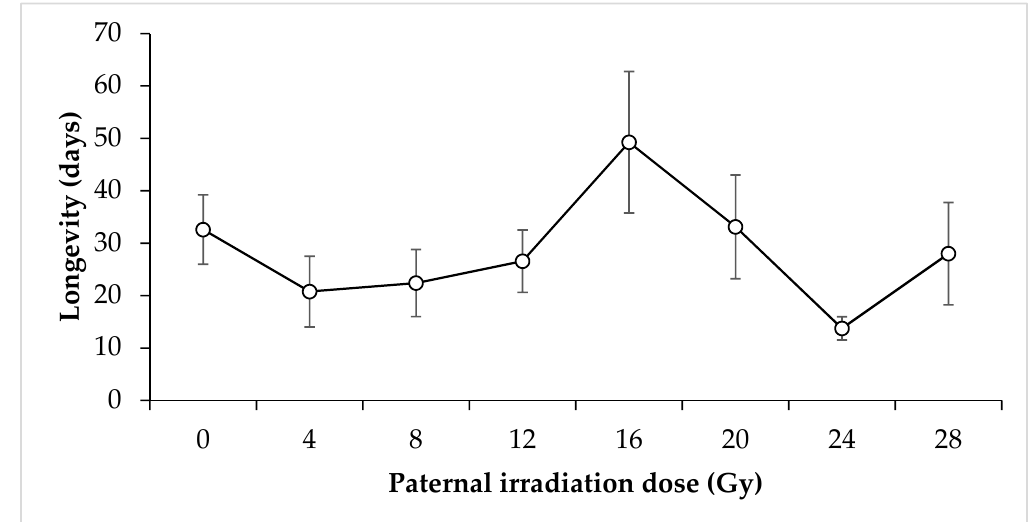
Figure 6. Mean longevity of irradiated male Nezara viridula that were crossed with untreated females. Error bars show standard error.